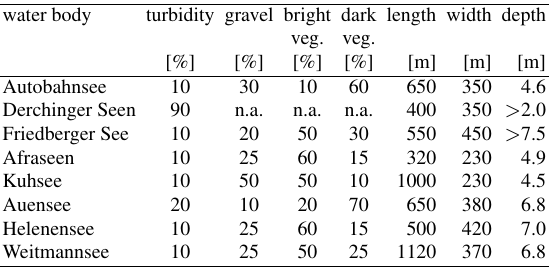
Table 1. Dimension and properties of selected